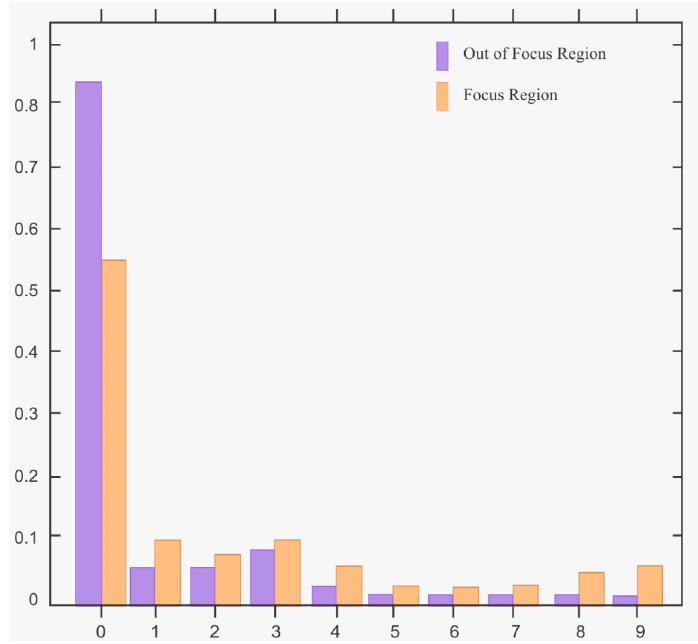
Figure 5. Histogram pattern in blurred and non-blurred regions.